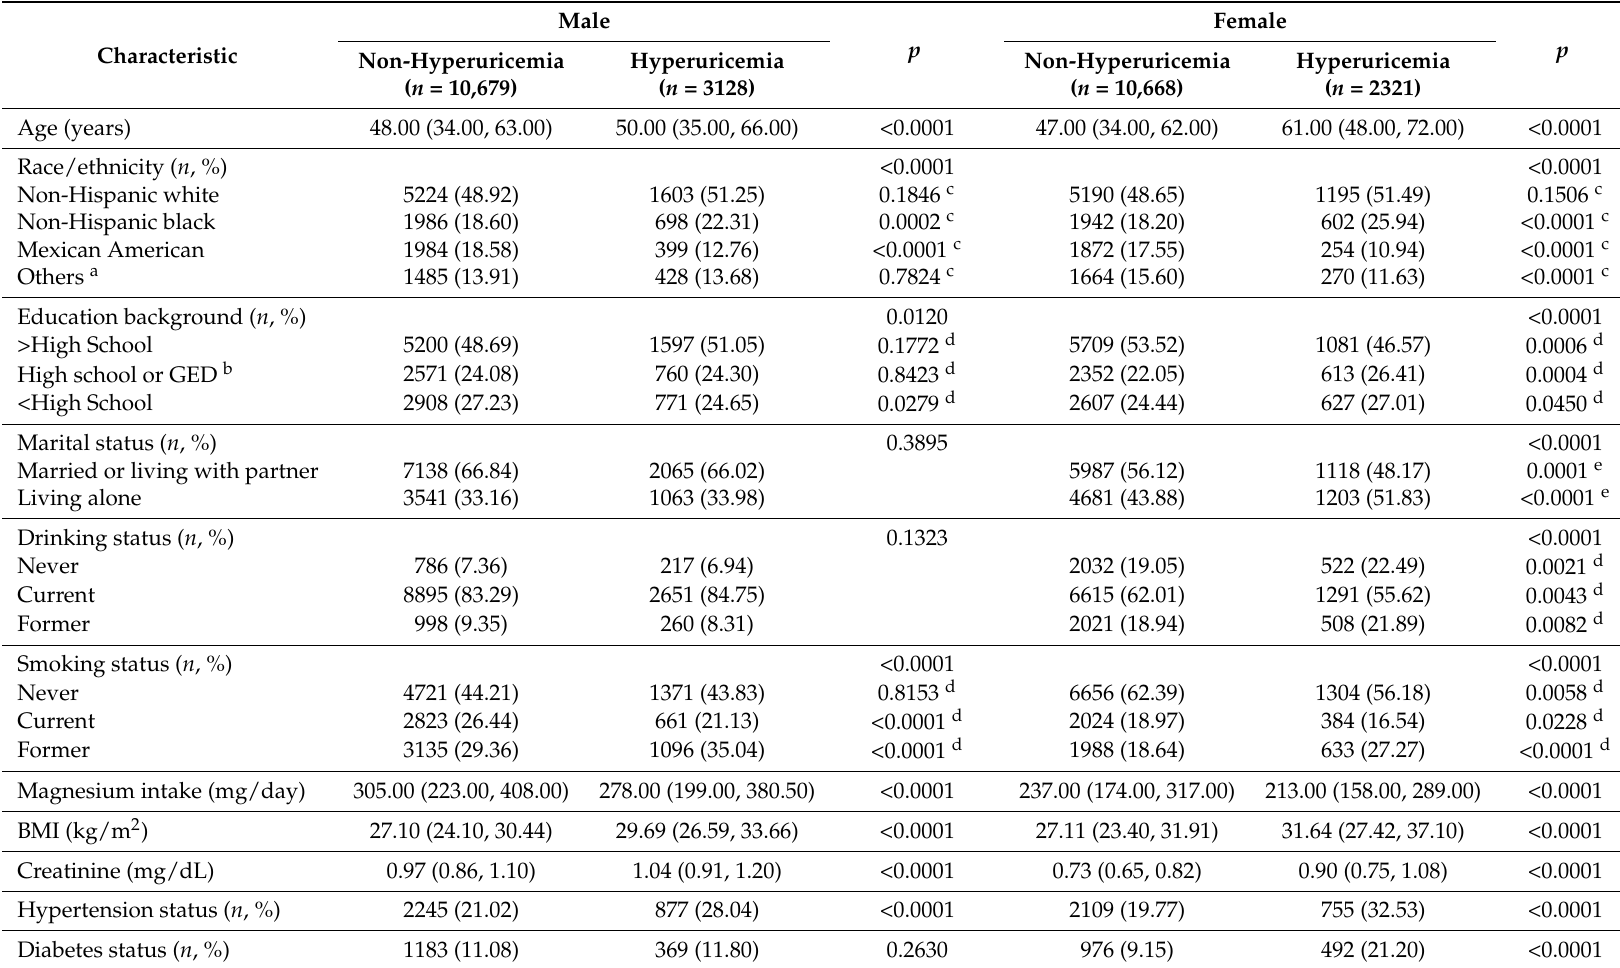
Table 2. Characteristics of participants with or without